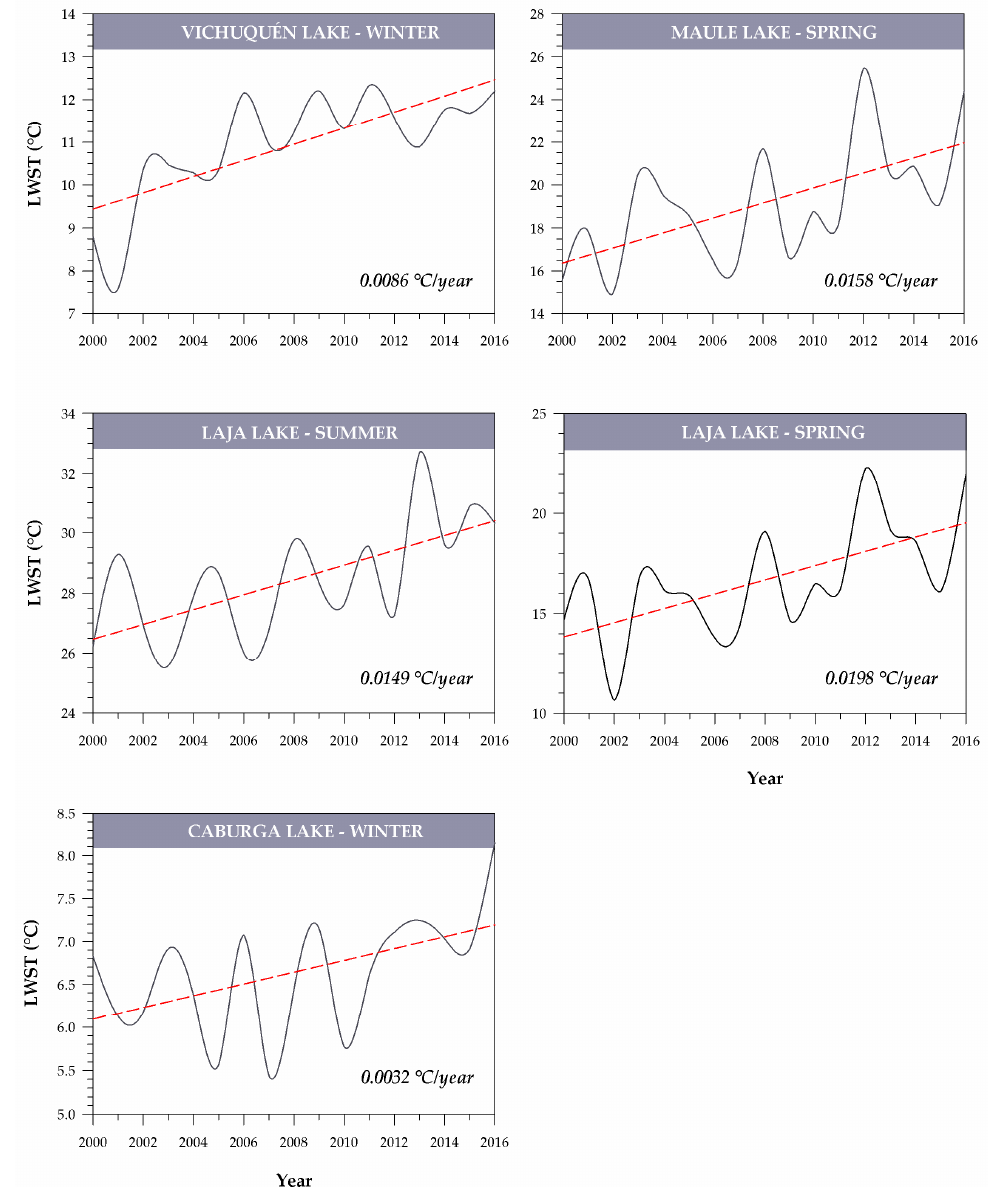
Figure 3. Temporal behavior and trends of the seasonal MODIS LSWT